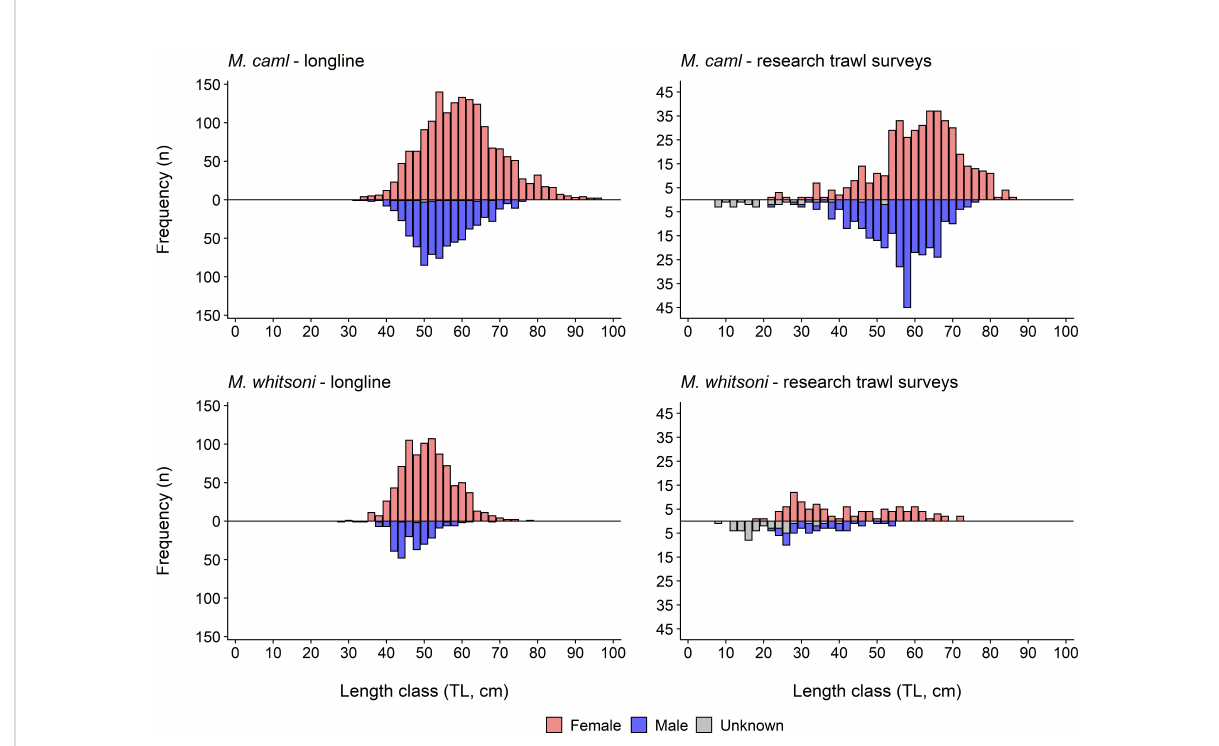
FIGURE 3 Length frequency distributions for female, male and unsexed Macrourus caml (top row) and M. whitsoni (bottom row) sampled from the Ross Sea region by longline (i.e., the commercial fi shery and the 2016 and 2019 winter surveys) (left column), and fi sheries-independent research trawl surveys in 2015 and 2019 (right column). Note the different y-axis scales between longline and research trawl